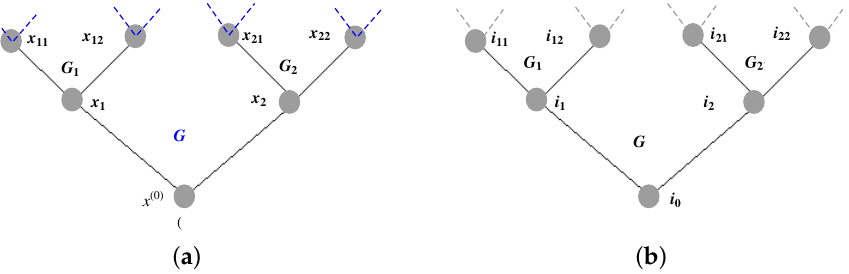
Figure 2. (Color online) ( a ) A semi-ball B 2 ( x ( 0 ) ) with the center x ( 0 ) and radius 2 on the second-order CT. ( b ) Possible configurations that can be placed on the semi-ball B 2